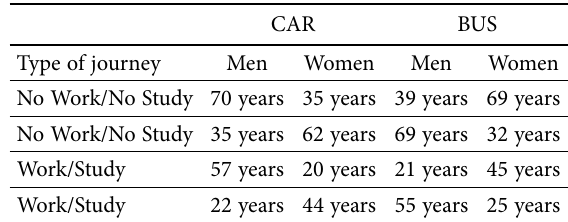
Table 1. Characteristics of the users participating in the focus